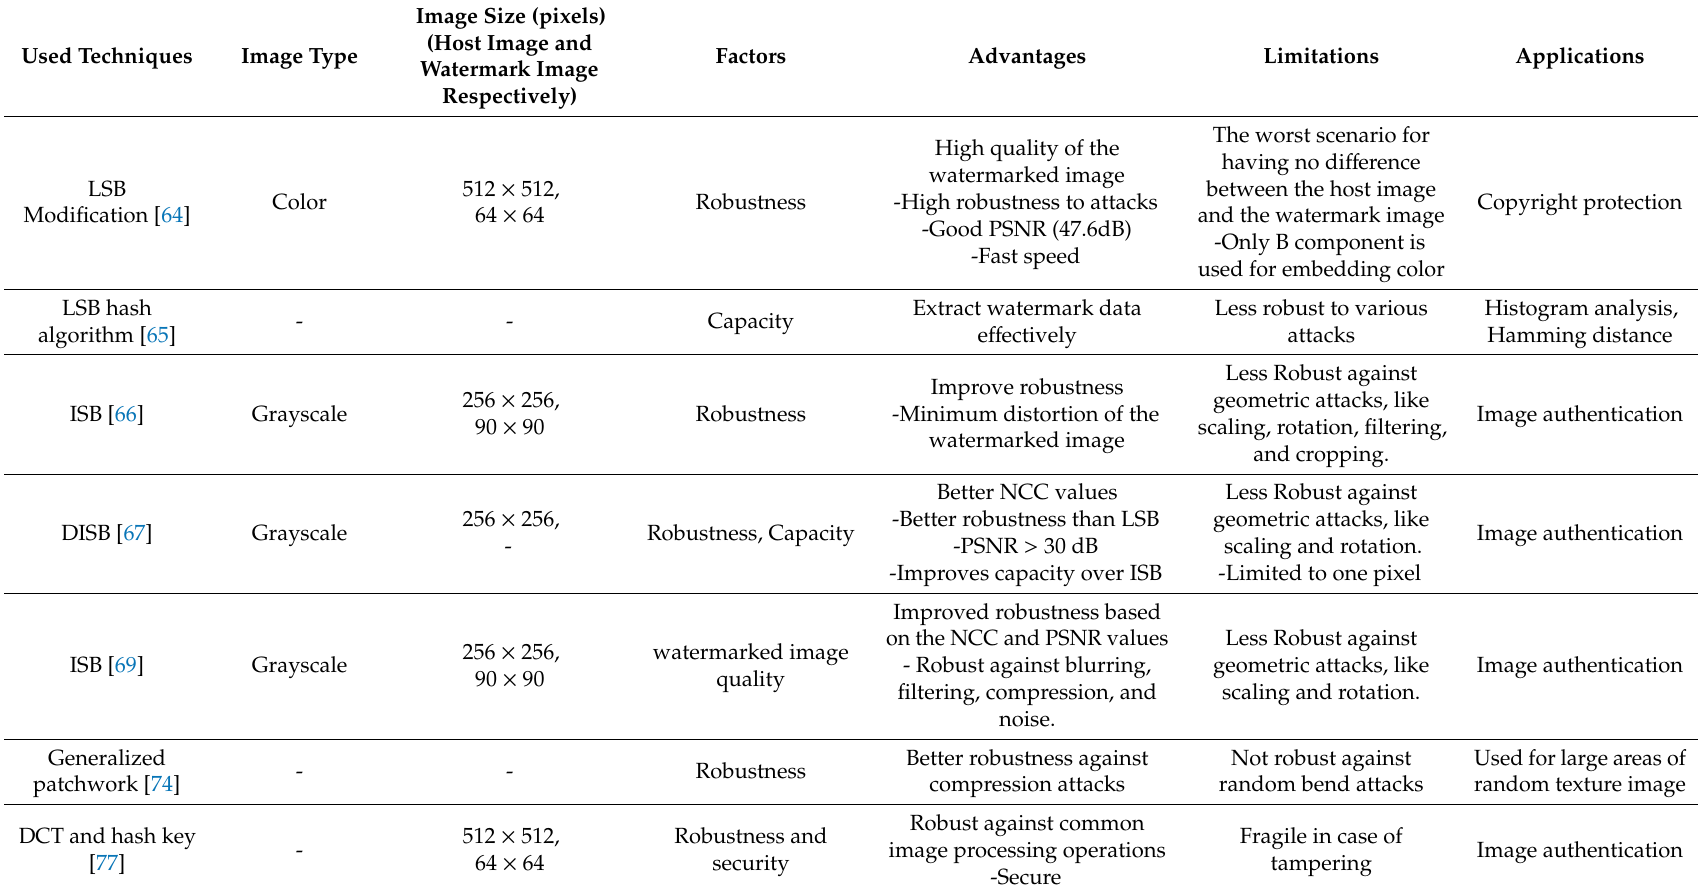
Table 3. Summary of state-of-the-art watermarking techniques